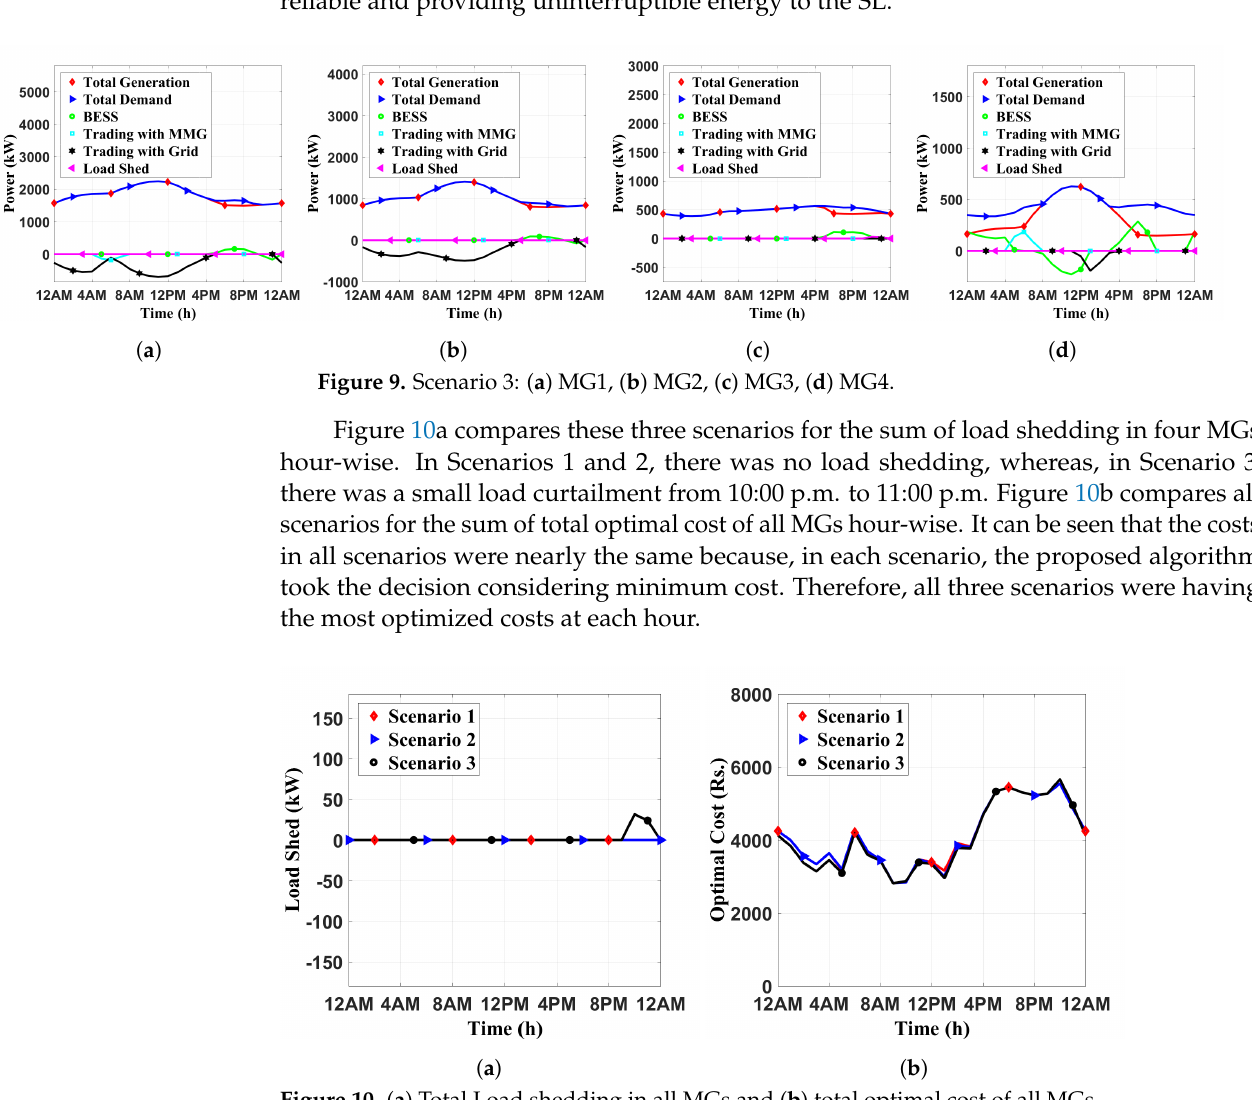
Figure 10. ( a ) Total Load shedding in all MGs and ( b ) total optimal cost of all